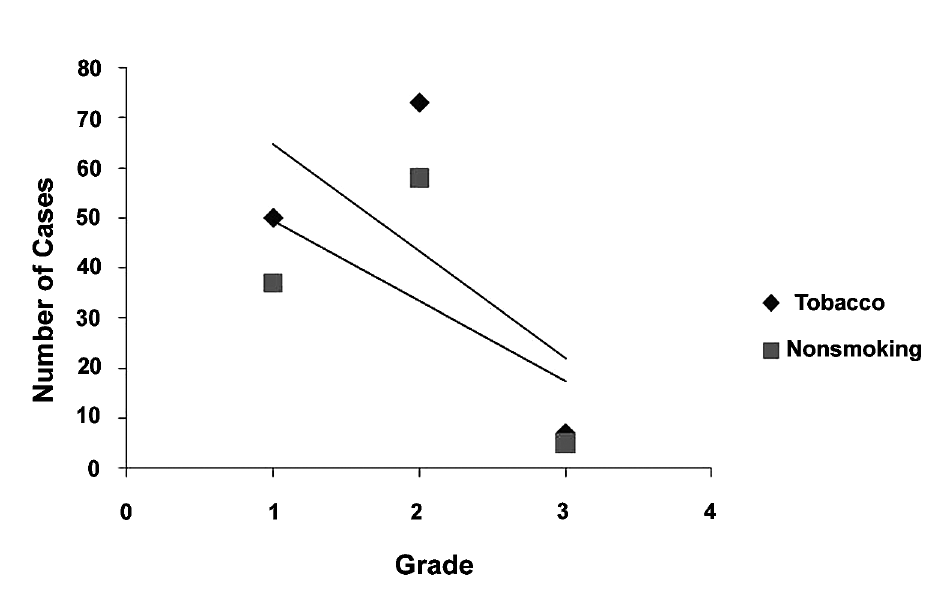
Figure 4 – In this case no linear correlation was found using regression analysis of 0.35 and 0.41 respectively for smokers and non-